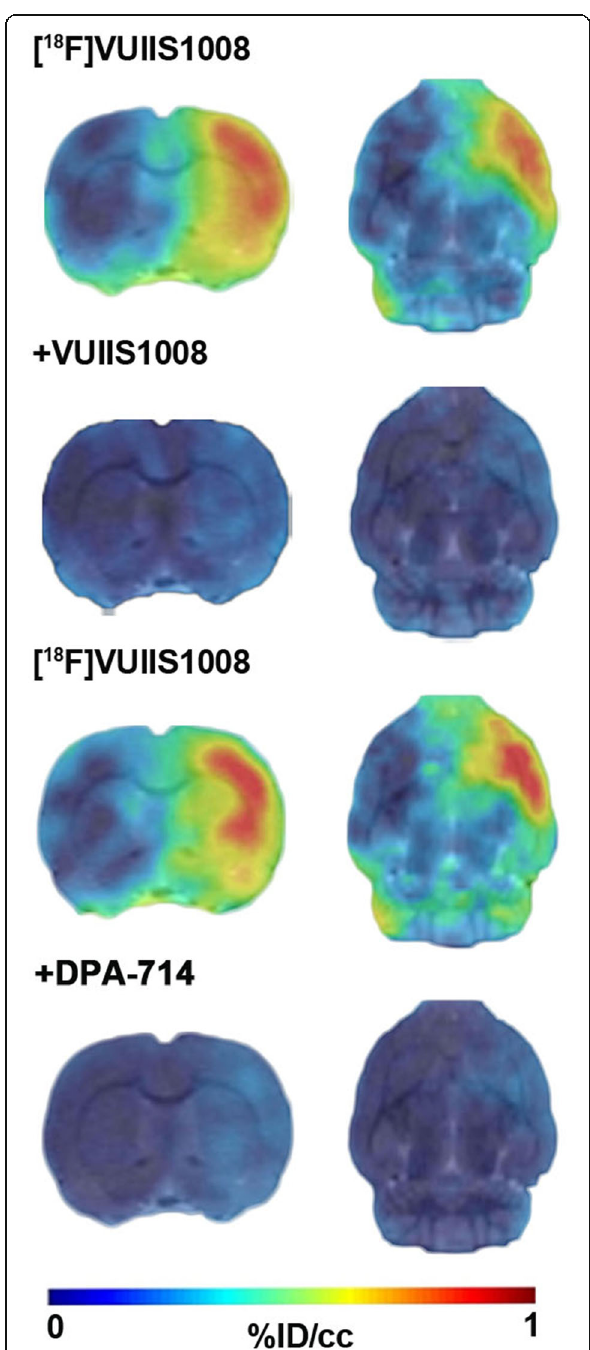
Fig. 6 Normalized PET images of [ 18 F] VUIIS1008 and displacements by VUIIS1008 and DPA-714. PET images (ID%/cc) of the coronal and horizontal planes at the level of the lesion from left to right. Summed images of [ 18 F] VUIIS1008 before displacement (0 to 20 min) and after displacement (40 to 60 min) by VUIIS1008 (upper row) and by DPA-714 (lower row). PET images were co-registered with a rat brain atlas for illustration of anatomical